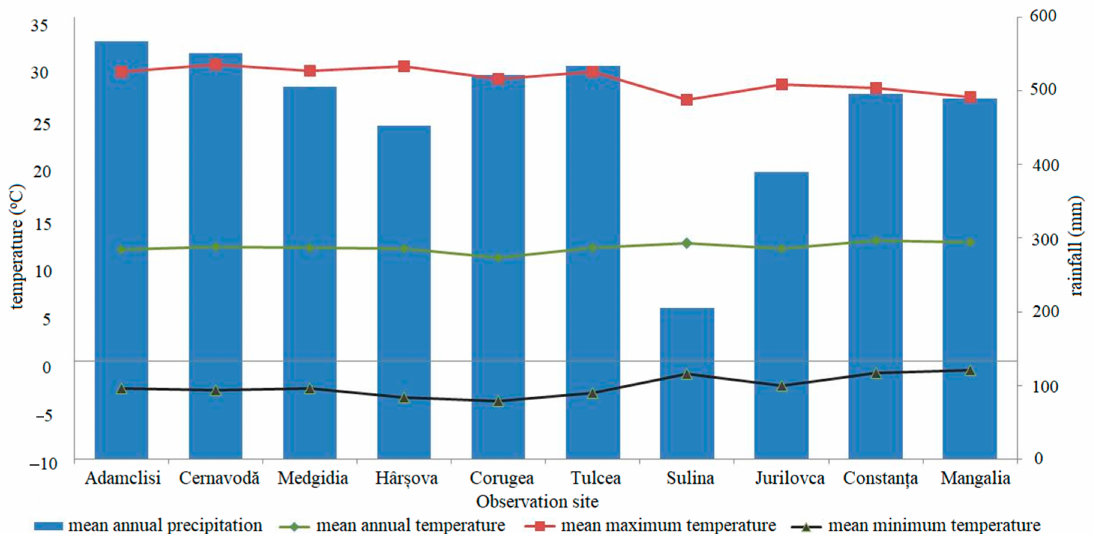
Figure 6. Principal climatic parameters at weather stations in the Dobrogea region (average 1998–2019). The multiannual precipitation (Rm) varied between 205 mm (Sulina) and 568 mm (Adamclisi). The average relative humidity (RH) in the region was 78.4% (77.8–84.2%). The day length varied between 8.9 h in December and 15 h in